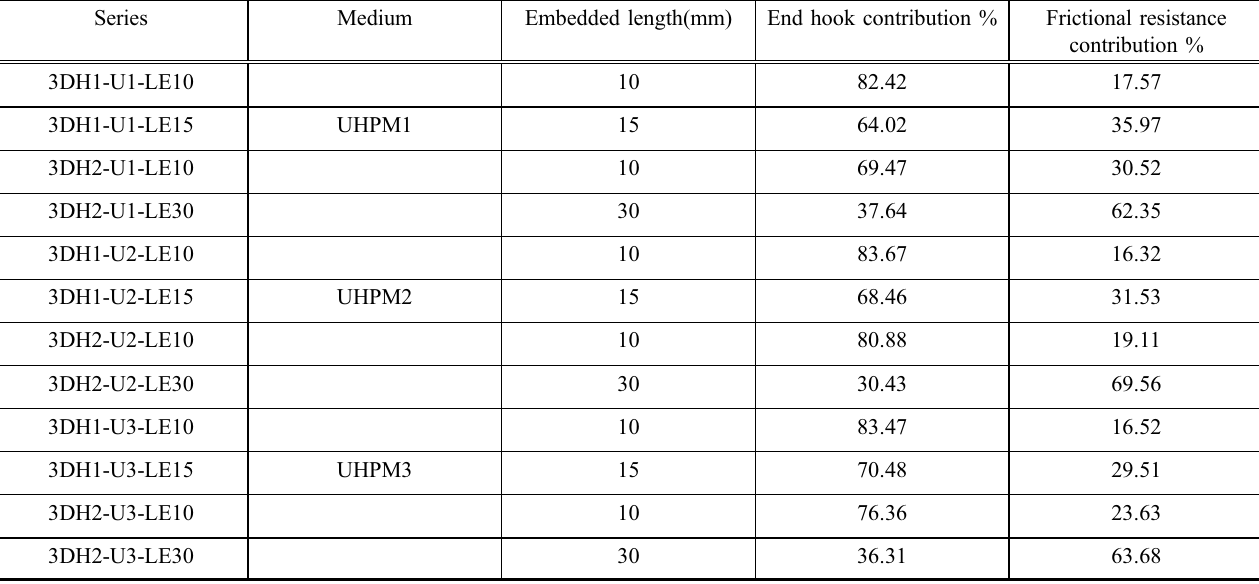
Table 5 The end hook and frictional resistance contribution to the total pullout